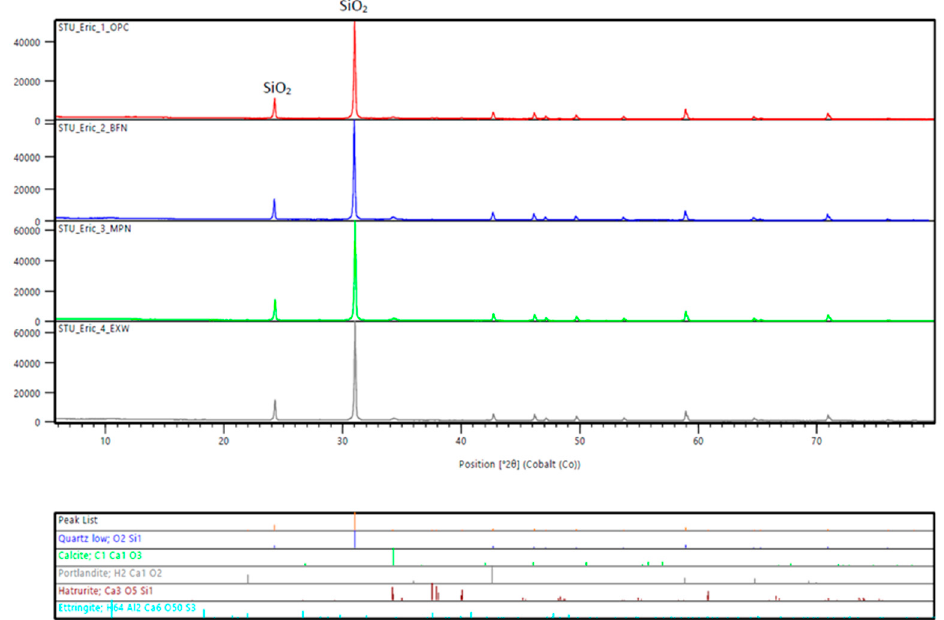
Figure 7. XRD patterns of the PC mortar (control in red), BFN (blue), MFN (green), and EXW (grey) at 28 days.